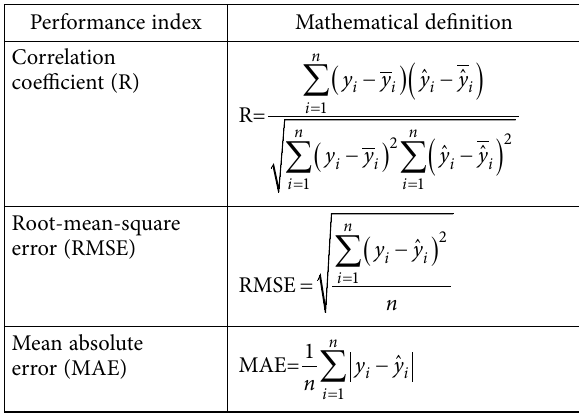
Figure 1. Flowchart of the IPSO-LSSVM Table 1. Statistical criteria used for the evaluation of models